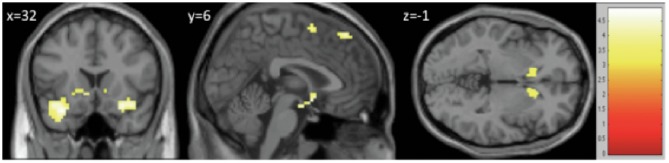
Differences between two groups (patients without FOG > patients with FOG).Slices of the brain representing the main regions of increased BOLD contrast in the comparison of patients without FOG > patients with FOG (corrected with a false detection rate of p<0.05) presented in the coronal (y = 6), sagittal (x = 32) and axial (z = −1) slices of a representative single T1 image. The major differences were found in the bilateral anterior insula, the bilateral ventral striatum and the pSMA. These differences were significant after controlling for group differences in motor severity, affective disturbance and impaired attentional set-shifting ability.